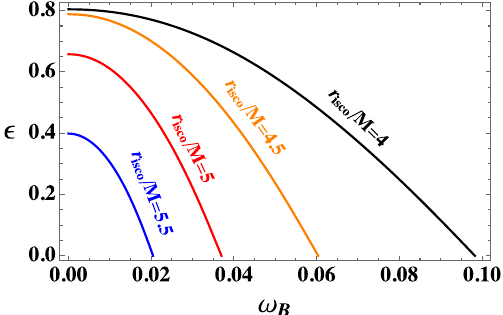
Fig. 5 Degeneracy plots for (cid:2) and ω B for given values of ISCO